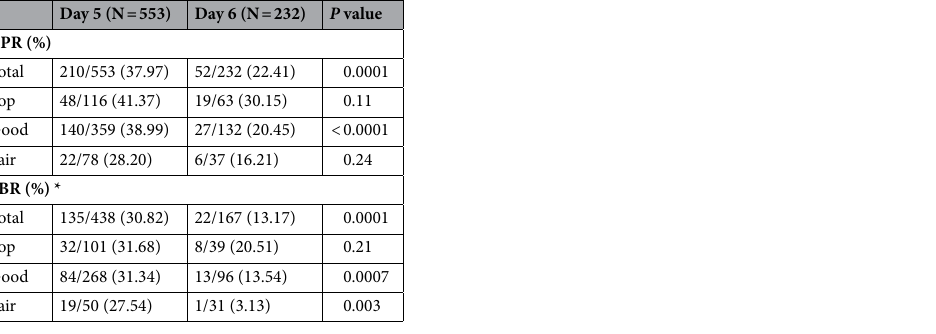
Table 3. Clinical outcomes of day 5 vs. day 6 ET, First ET Only. Data is presented in mean ± standard error or percentage. CPR—clinical pregnancy rate, *LBR—live birth rate, derived from ET before 2/2019.